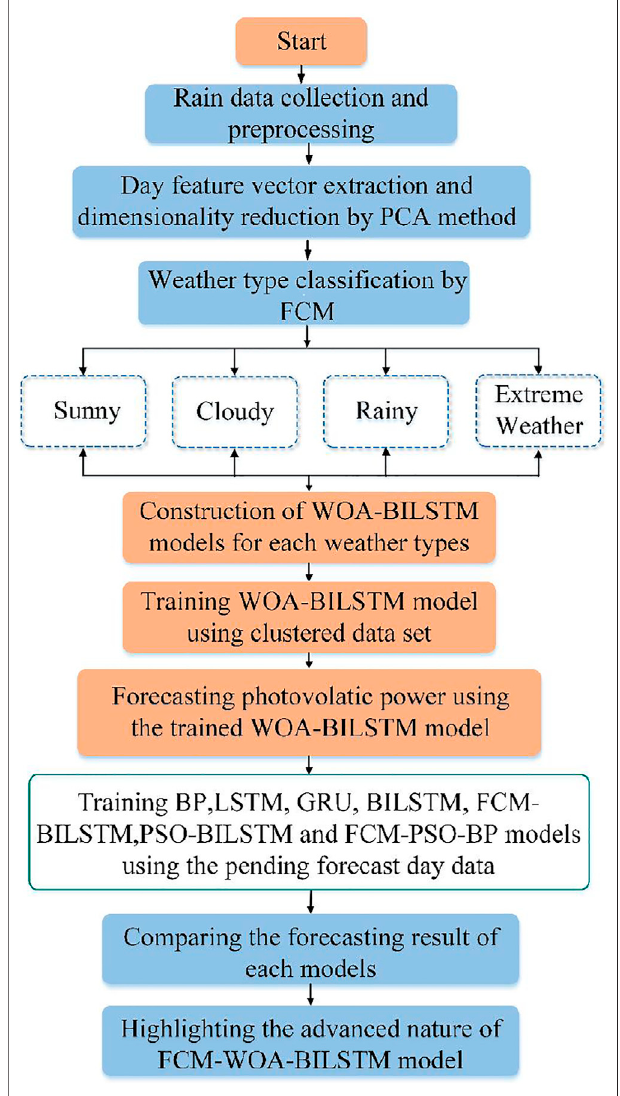
FIGURE 4 | FCM-WOA-BILSTM model prediction fl ow